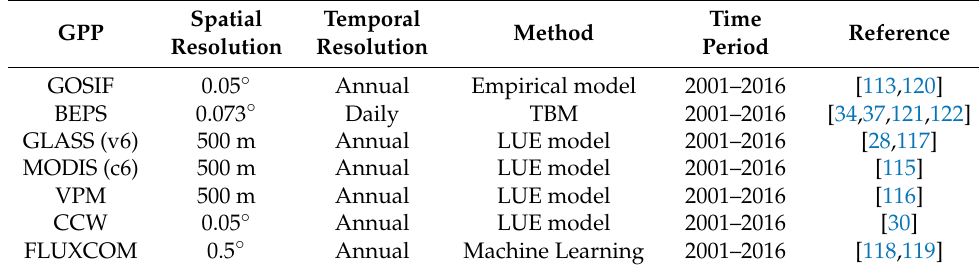
Table 4. Information on nine GPP products for intercomparison.